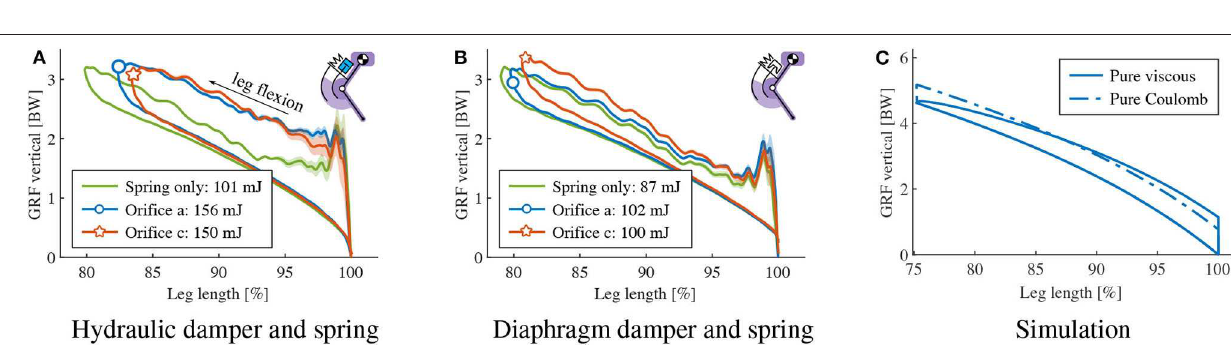
( E cfriction ) and the impact loss E impact due to unsprung masses: E effective = E cfriction + E impact + E viscous .